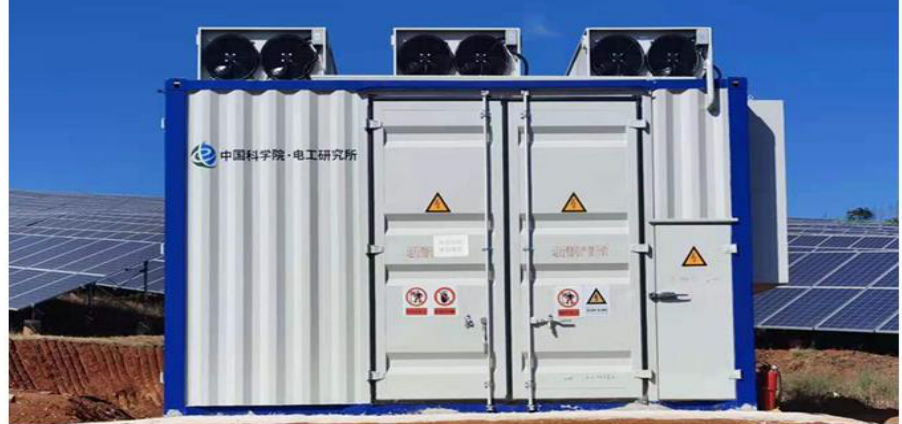
Figure 24. ± 30 kV/1 MW DC/DC converter engineering prototype. Figure 24. ±30 kV/1 MW DC/DC converter engineering prototype. Figure 24. ±30 kV/1 MW DC/DC converter engineering prototype. Figure 24. ±30 kV/1 MW DC/DC converter engineering prototype.